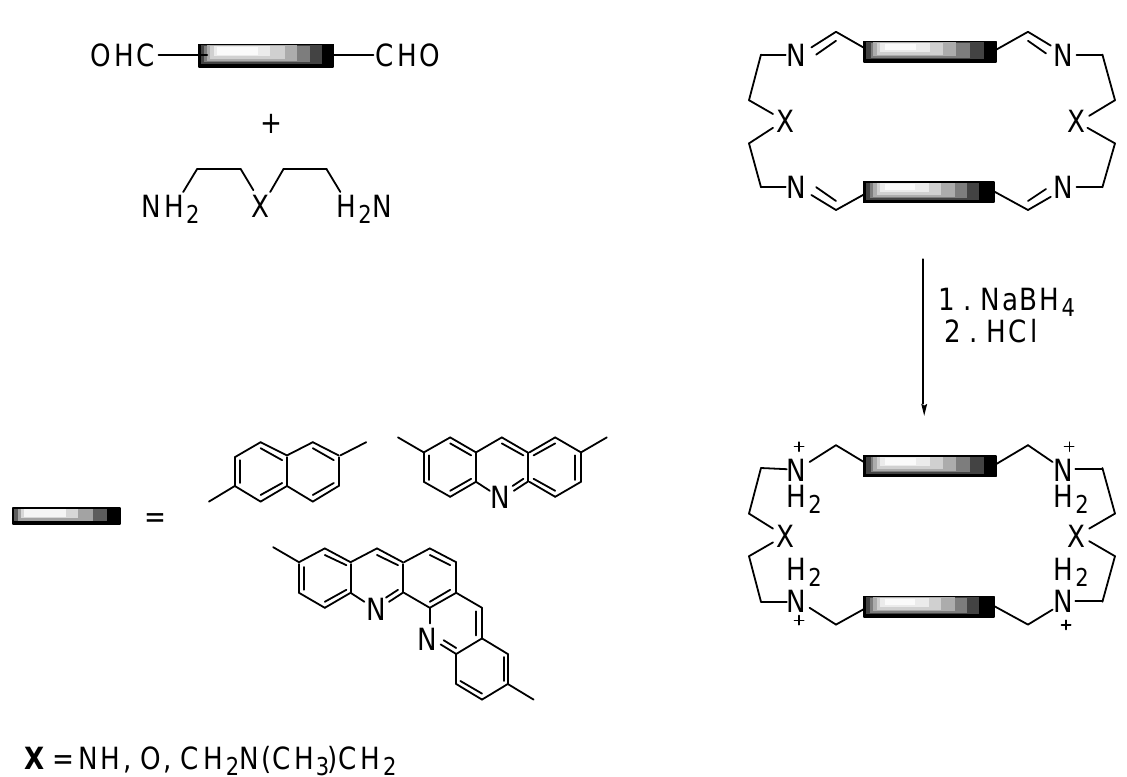
Figure 4. General synthesis of